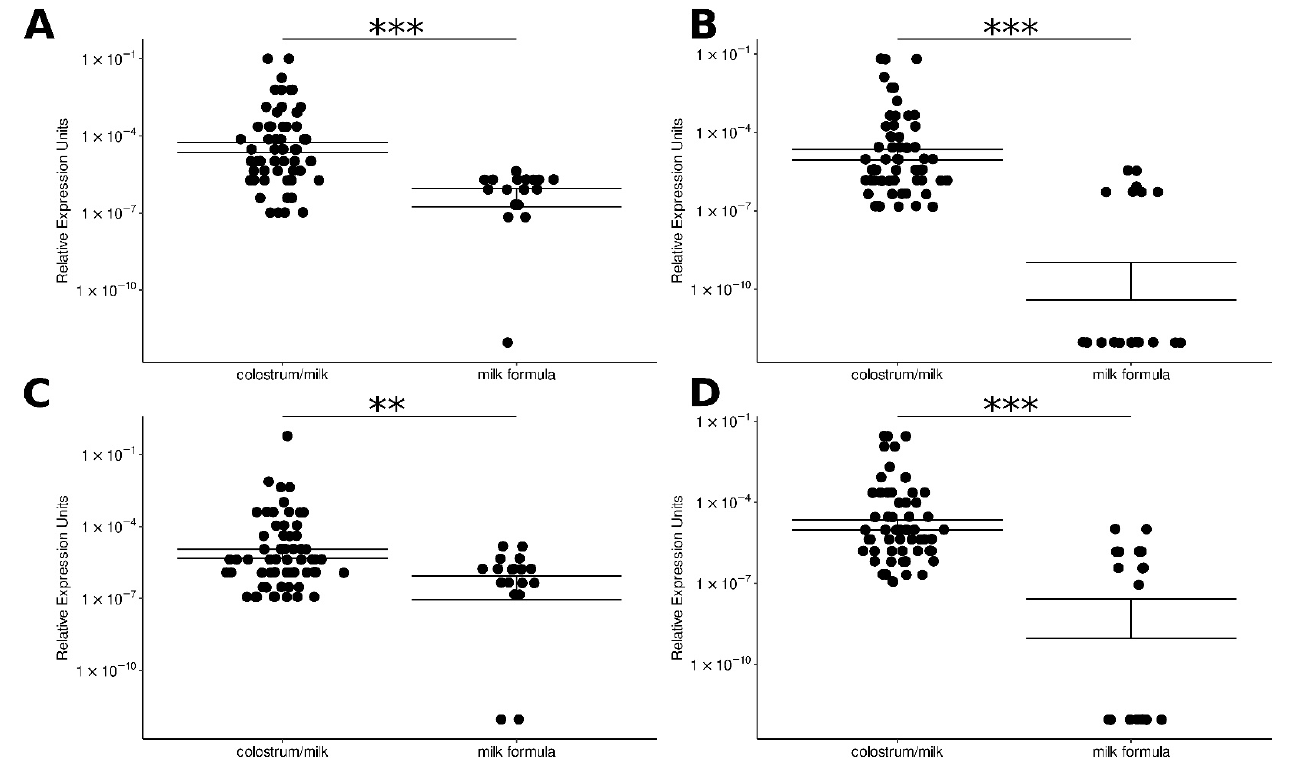
Figure 2. Comparative expression of selected hsa-miRs in colostrum/milk (n = 60) with respect to milk formula (n = 18). The graphics show the relative expression of each miRNA with respect to the internal control cel-miR-39. ( A ) hsa-miR-146, ( B ) hsa-miR-148, ( C ) hsa-miR-155, ( D ) hsa-miR-200. The Y-axis shows the relative expression of each miRNA, and the X-axis shows the type of sample. Each dot in the plot represents a sample. The double horizontal lines indicate the standard error of the mean. Mann-Whitney U (Wilcoxon rank-sum) test was made. ** indicates p < 0.01 and *** indicates p < 0.001.